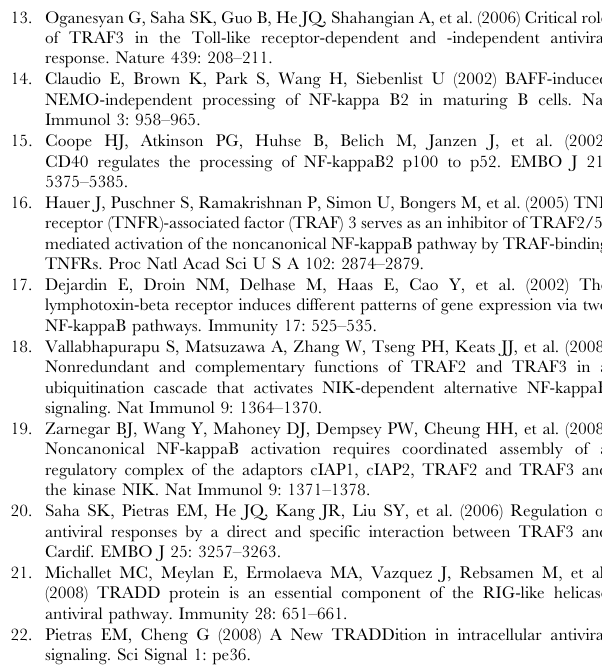
the cellular distribution of TRAF3. Bars represent 5 m m. One of three independent experiments with similar results is shown. Figure S5 COPI/COPII-vesicular retention of the TRAF3- AKKFF mutant affects its extraction efficiency as well as interaction with MAVS. 293T cells were co-transfected with Myc-MAVS and the indicated FLAG-TRAF3 constructs (wtTRAF3 or TRAF3-AKKFF). 24 h post-transfection, whole cell extracts were prepared using 1% Triton X-100 or RIPA lysis buffers as indicated. Cellular extracts were then subjected to immunoprecipitation using anti-FLAG antibodies or used in Western blot analysis (Input). Following multiples washing steps, immunoprecipitated proteins were then subjected to Western blot analysis using the indicated antibodies. Interestingly, using a soft lysis condition (1% Triton X-100), we were not able to extract the same amount of the two TRAF3 populations in the IP and in the INPUT (left panels), most likely due to the ability of the TRAF3- AKKFF mutant to be retained in the rich vesicular COPI/COPII environment. On the other hand, the use of a RIPA buffer helped the extraction of the TRAF3-AKKFF mutant from its vesicular- rich environment (right panels). However under these conditions, we might have disrupted the COPI/COPII vesicles, releasing the TRAF3-AKKFF mutant into the cell lysate and allowing its interaction with MAVS. Nonetheless, a lower amount of the TRAF3-AKKFF mutant was detected in the Myc-MAVS immunocomplex compared to wtTRAF3 (right panels). Figure S6 Mild expression of Sec16A and p115 in Hec1B cells increases activation of ISG56 and NF- k B promoter. ( A–C ) Hec1B cells were co-transfected with pGL3-ISG56-luciferase reporter gene, 125 ng of empty vector, Myc-p115 or Sec16A and 15 ng of His-TRIF ( A ), 15 ng of FLAG-MAVS ( B ) or 100 ng of FLAG- TBK1 ( C ). ( D–F ) Hec1B cells were co-transfected with pGL3- NF- k B-luciferase reporter gene together with 125 ng of empty vector, Myc-p115 or Sec16A and 60 ng of His-TRIF ( D ), 60 ng of